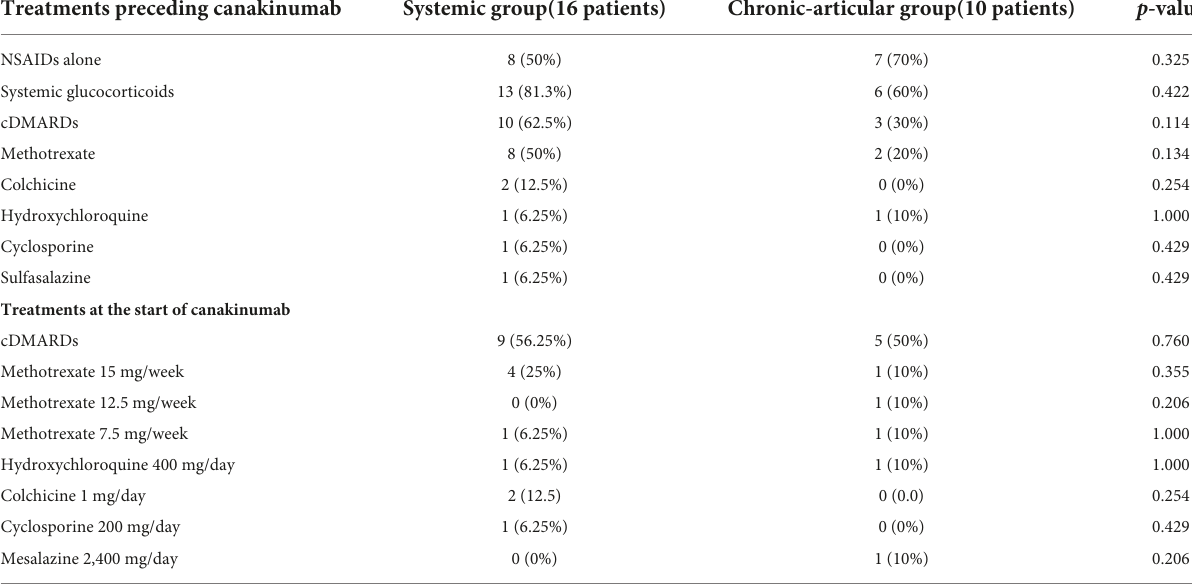
TABLE 1 Summary of treatment approaches performed in the study group prior to and concomitantly with the start of canakinumab. Treatments preceding